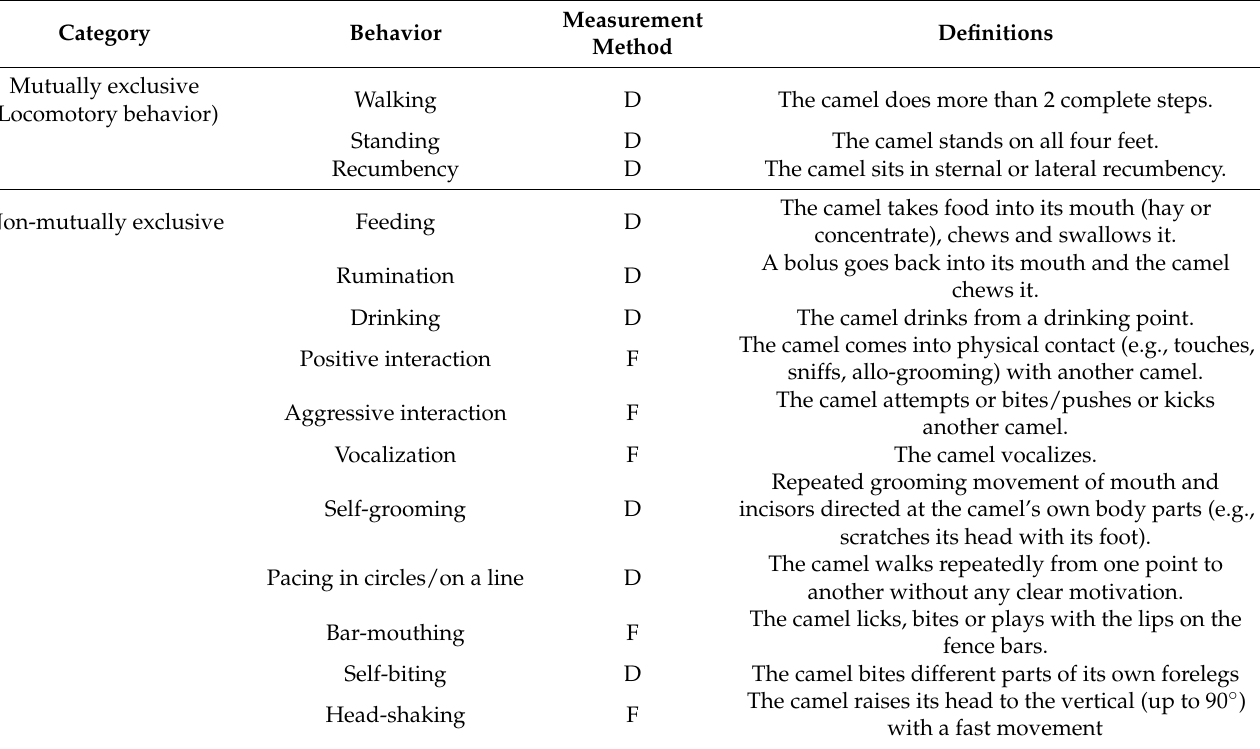
Table 1. Ethogram used for analyzing the behavior of dromedary camels kept with and without shade at the dromedary camel market in Doha, Qatar. Behavior was analyzed using an ad libitum sampling method. Variables were measured as duration (D) or frequency